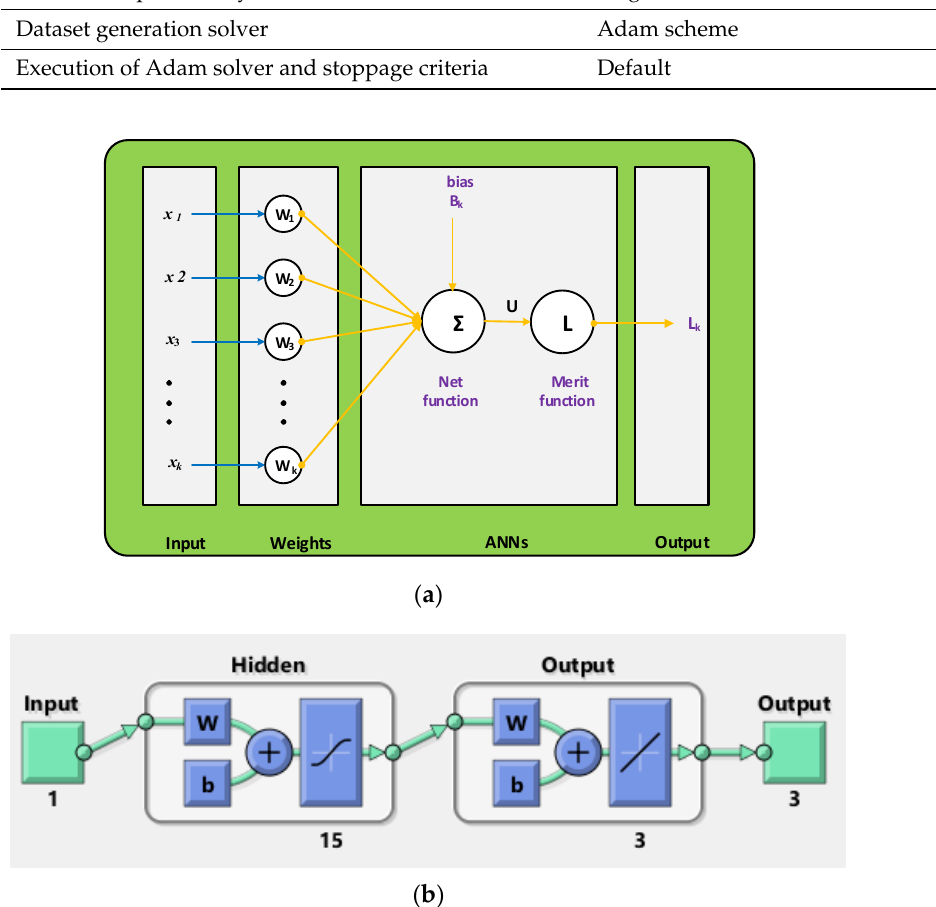
Figure 2. Generic and specific ANNs structure to solve the FKFS model. ( a ) Generic structure of single neuron; ( b ) Designed layer structure, a single input layer vector having 15 hidden numbers of neurons in the hidden layer along with the three outcomes in the outer layer.